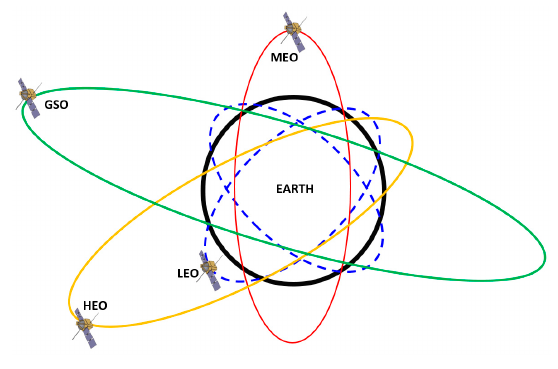
Figure 4. Standard satellite orbits.